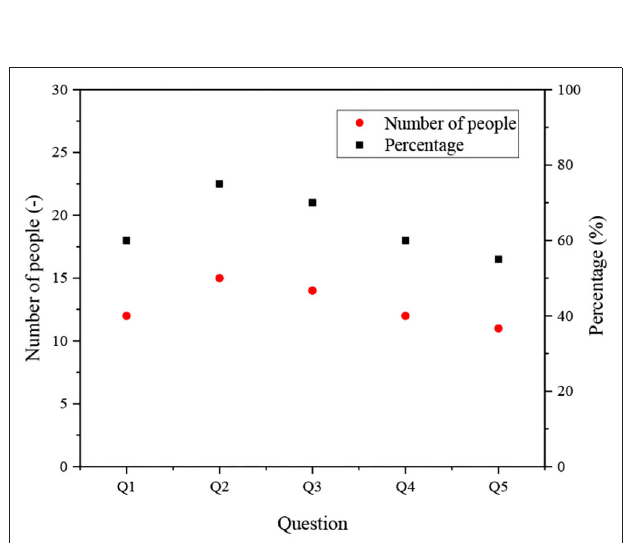
FIGURE 9 | Innovation behavior analysis of the college-student entrepreneur.